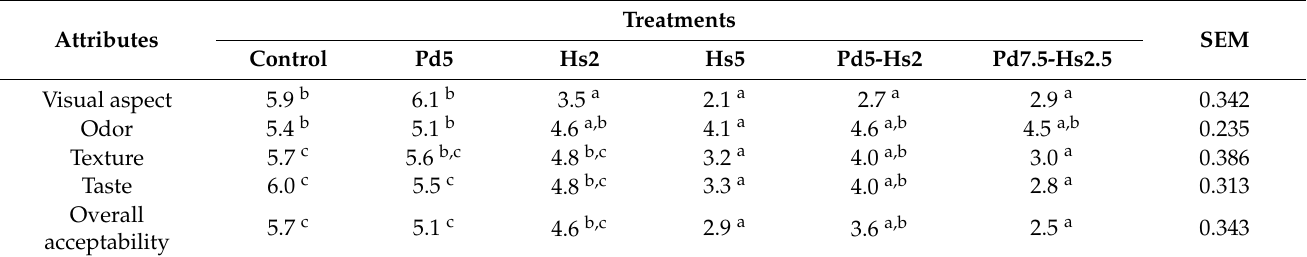
Table 6. Acceptance test results of beef patties evaluated at day